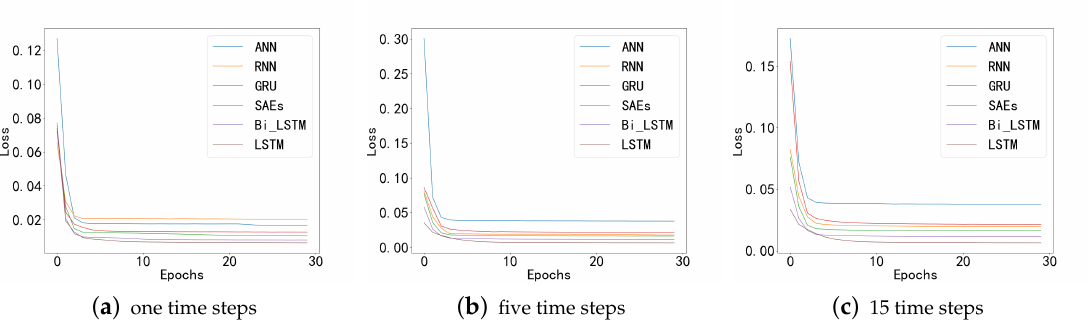
Figure 9. Loss curve comparison in three time